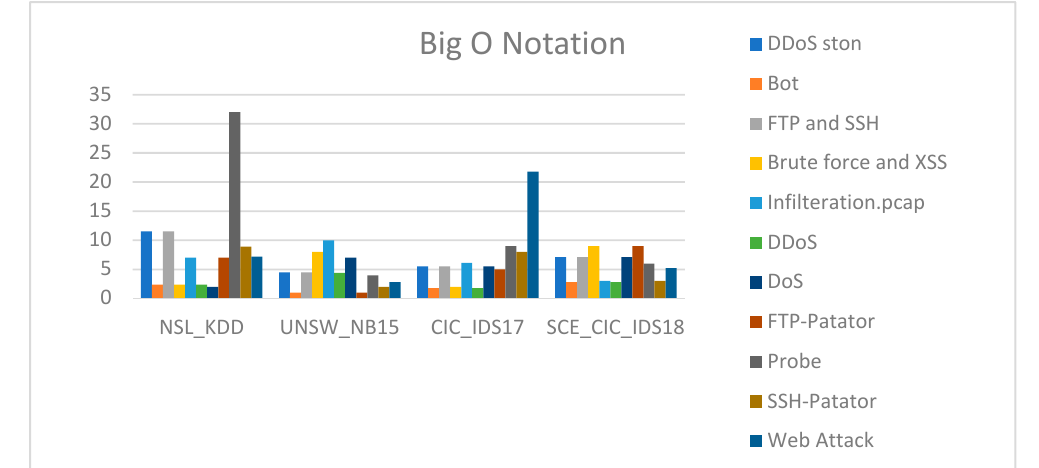
Figure 8. Big O notation idea for four datasets.